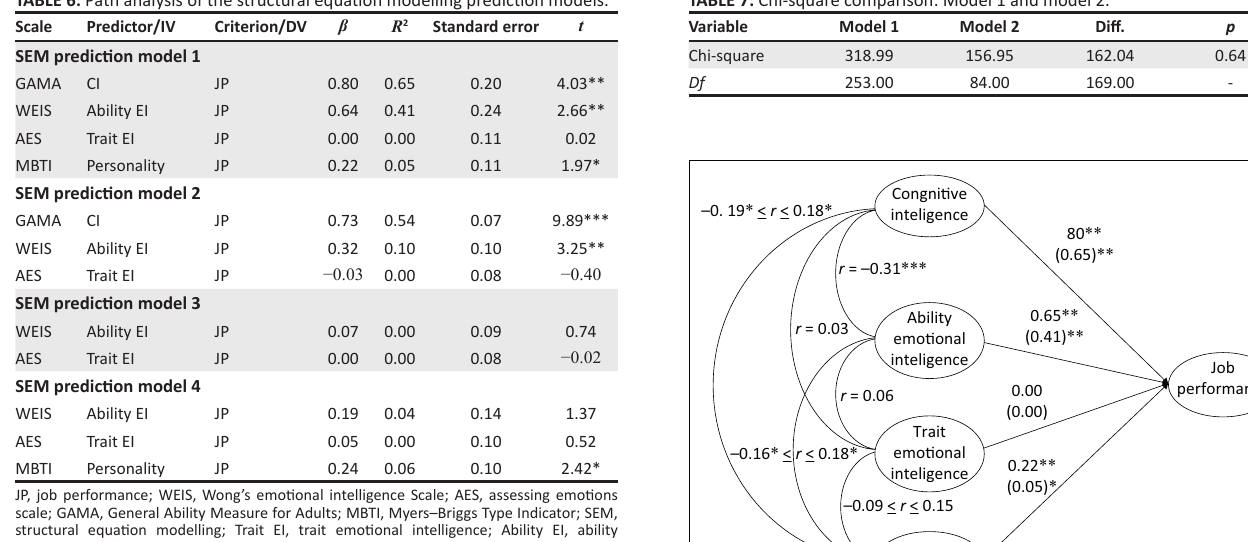
TABLE 7: Chi-square comparison: Model 1 and model 2.